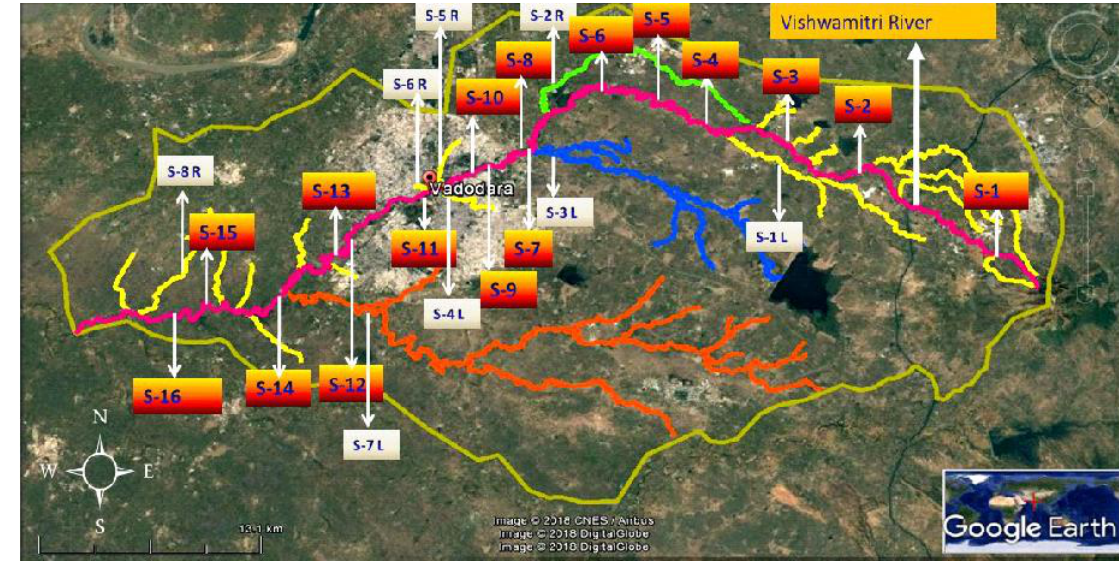
Fig.1 : Study area representing sampling stations in Vishwamitri